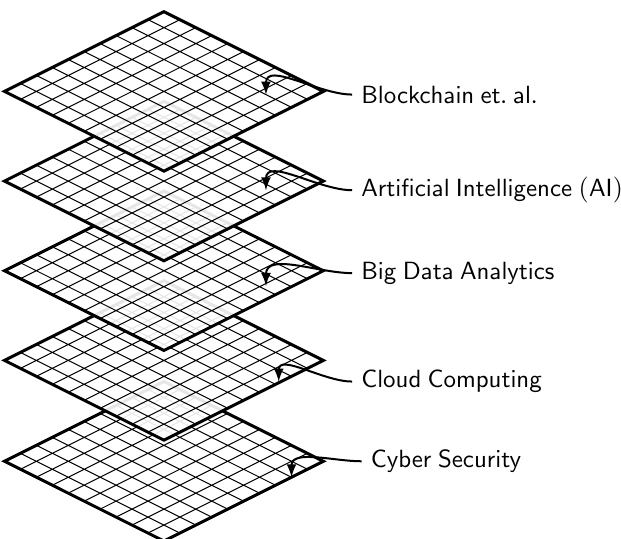
Figure 19. Layers of transformative technologies shaping the Future